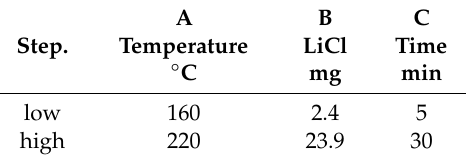
Table 1. Factor steps of the experiment plan of the first DOE approach.